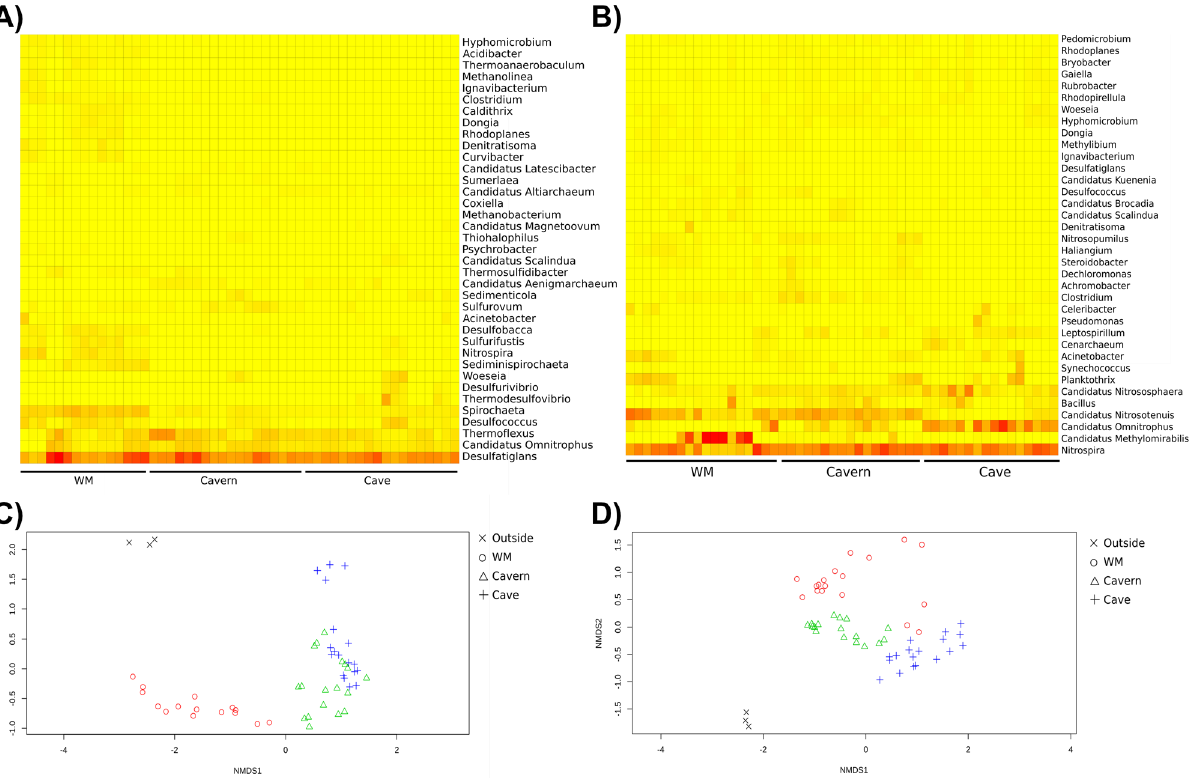
Figure 3. Taxonomic and beta diversity in the sediment zones. (1) Heat map of the 20 most abundant genera for each sediment zone in the coastal ( A ) and inland ( B ) sinkholes, the columns represent sediment sample, rows depict genera. Low abundance (yellow), medium abundance (orange) and high abundance (red). (2) Beta diversity analysis of the sediment samples. Non-metric multidimensional scaling (nMDS) plot based on